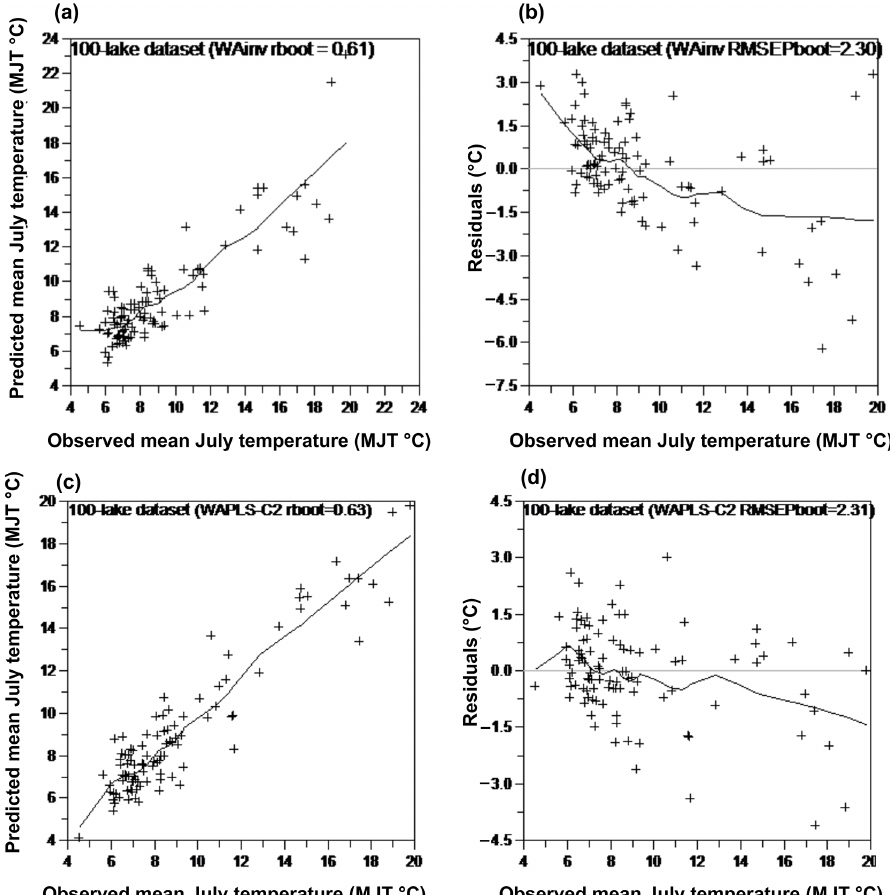
Figure 4. Performance of the weighted-average models with inverse deshrinking (WAinv) and partial least squares (WA-PLS) models using the 100 lakes calibration data sets: (a) WAinv bootstrap model; (b) the second component of the WA-PLS bootstrap model. Diagrams on the left show the predicted versus observed mean July temperature (MJT) and diagrams on the right display residuals of the predicted versus observed mean July temperature. Note that both models have a tendency to overpredict temperatures from the cold end of the gradient and underestimate temperatures at the warm end. This is typical for the WA-based